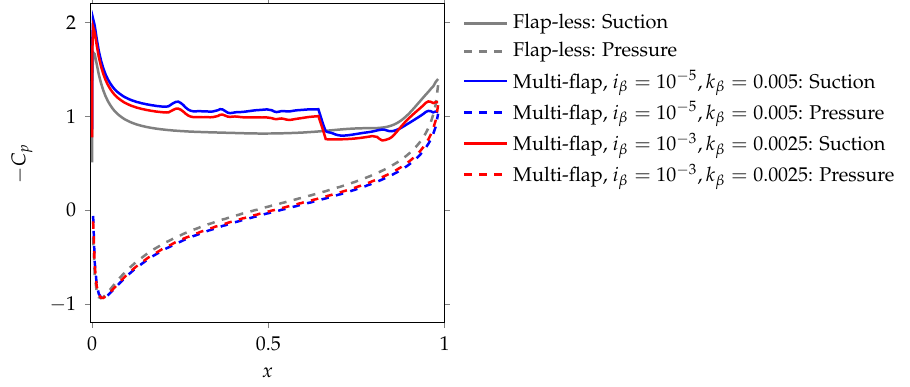
Figure 8. Mean C p distribution on the airfoil surface.